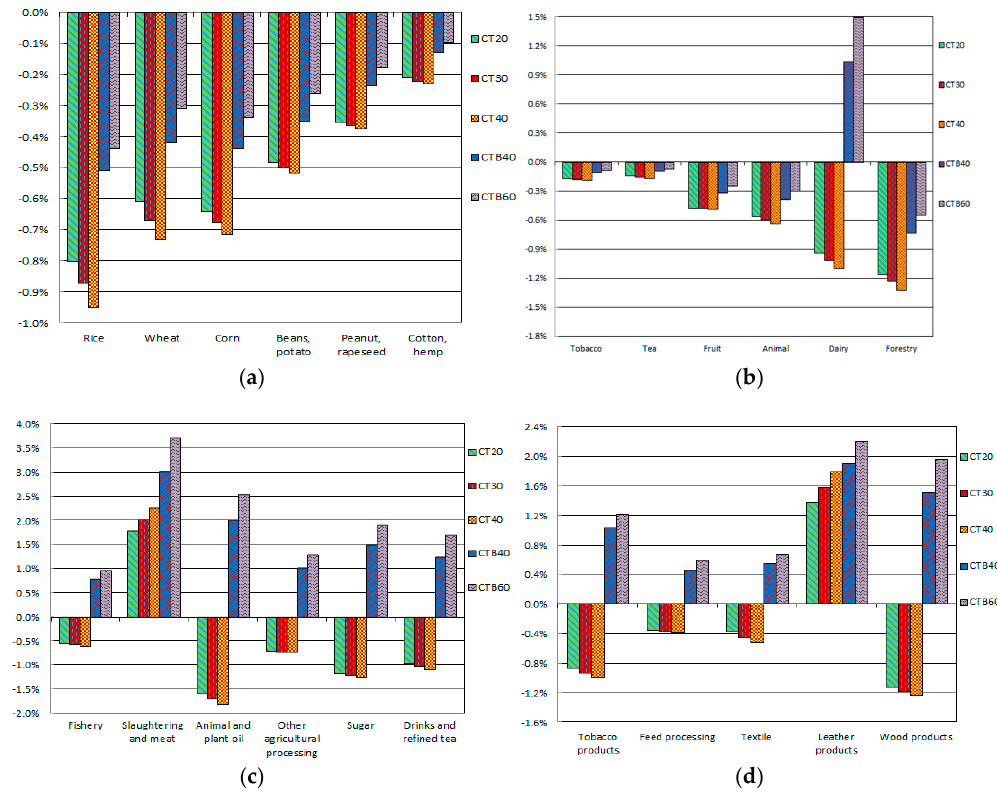
Figure 6. The changes in the households’ income in agriculture-related sectors under different scenarios (compared with the BAU scenario). Table 11. The changes in the households’ income in agriculture-related sectors under different scenarios compared with the BAU scenario (%) (from rice to tea).